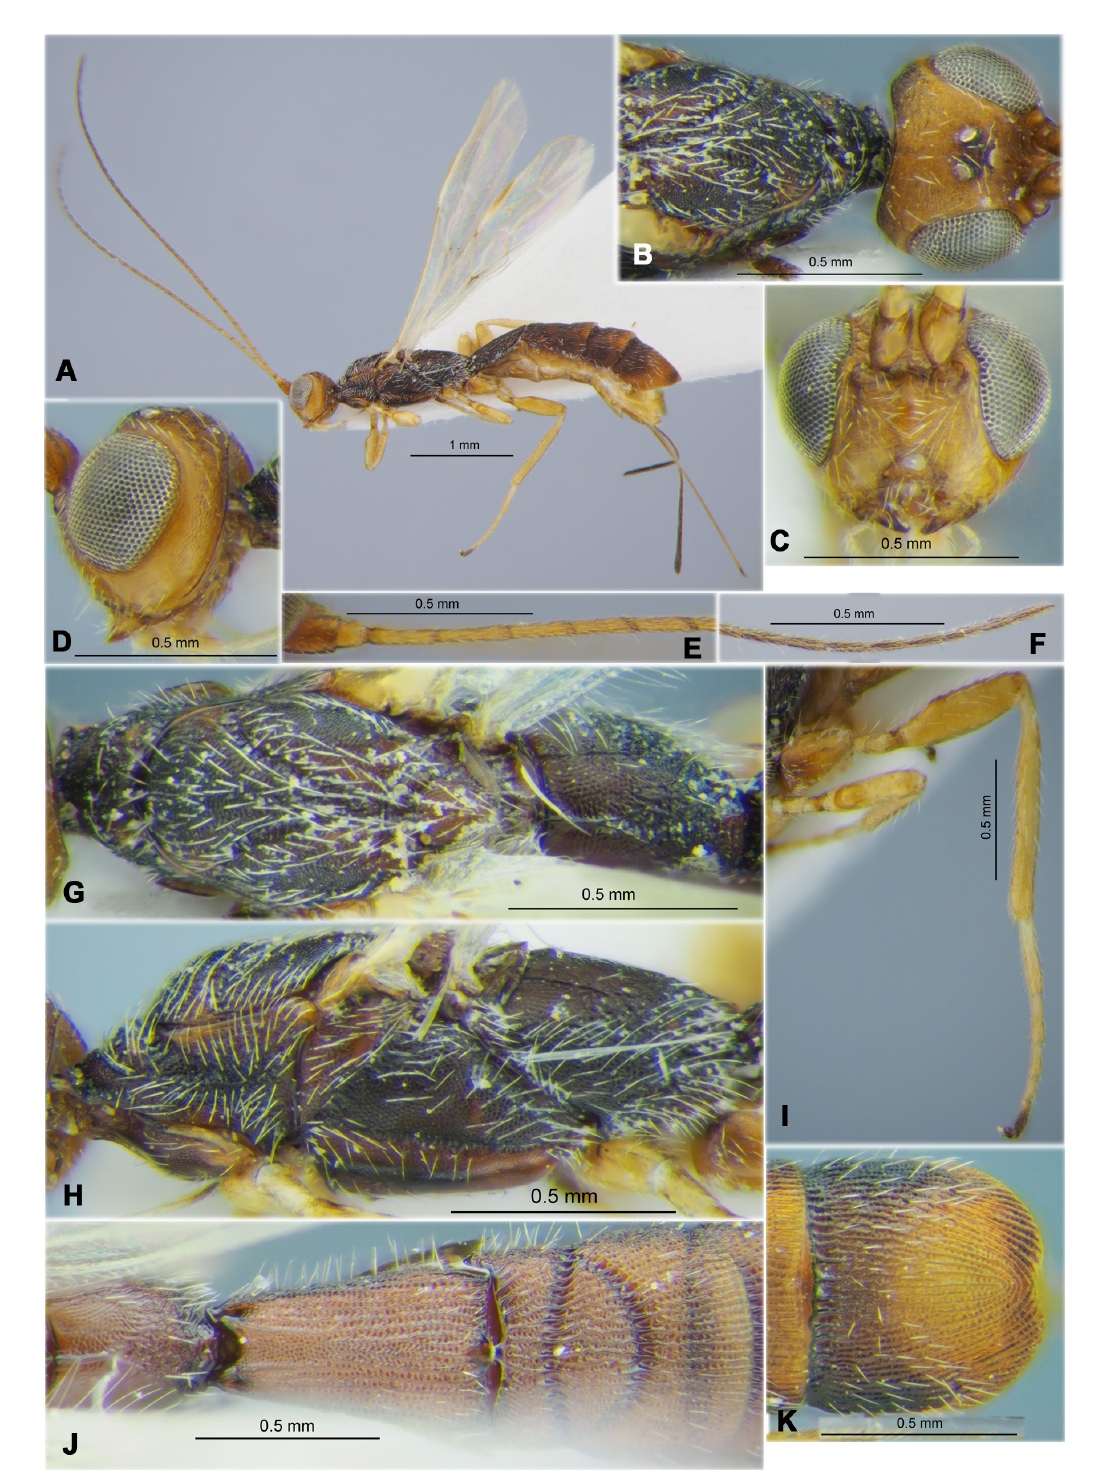
Fig. 55. Rhaconotus ( Rh. ) microexcavatus Belokobylskij sp. nov., holotype, ♀ (RMNH). A . Habitus, dorsal view. B . Head and mesoscutum, dorsal view. C . Head, front view. D . Head, lateral view. E . Basal segments of antenna. F . Apical segments of antenna. G . Mesosoma, dorsal view. H . Mesosoma, lateral view. I . Hind leg. J . Propodeum and first to third metasomal tergites, dorsal view. K . Fifth metasomal tergite, dorsal